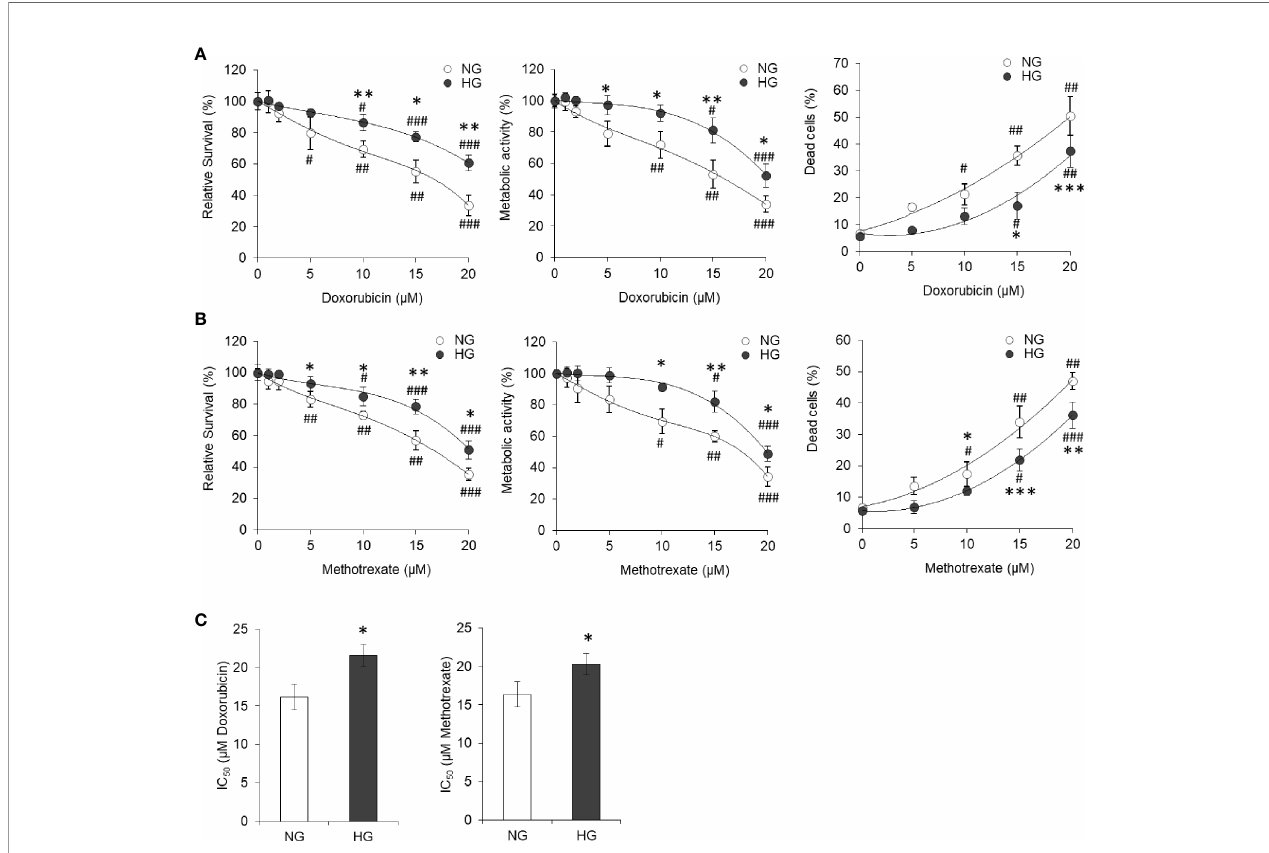
FIGURE 2 | High glucose promotes the chemoresistance HepG2 cells. HepG2 cells incubated in NG or HG medium with increasing concentration of anticancer drugs doxorubicin (A) and methotrexate (B) for 24 h followed by estimation of cell survival (left panels), metabolic activity (middle panels), and enumeration of percentage of dead cells (right panels). IC 50 was estimated for cells incubated in NG or HG medium for both the anticancer drugs doxorubicin and methotrexate (C) . The values shown are Mean ± SD of three independent experiments conducted in triplicate. * p < 0.05, ** p < 0.01, *** p < 0.001 vs values of cells incubated in NG medium. # p < 0.05, ## p < 0.01, ### p < 0.001 vs values of cells incubated in medium without anticancer